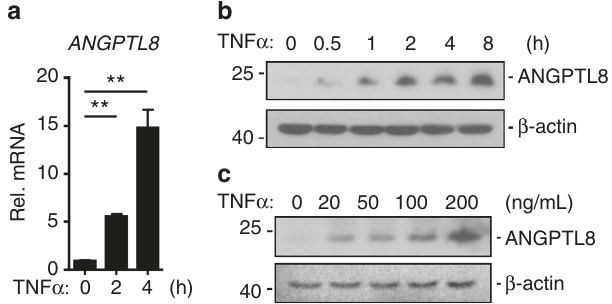
Fig. 1 TNF α upregulates the expression of ANGPTL8 in HepG2 cells. a , b The transcription level ( a , n = 3) and protein level ( b ) of ANGPTL8 after TNF α (50 ng/mL) treatment. The following experiments used the same dose of TNF α if not mentioned. c The protein level of ANGPTL8 at 8 h after different dosages of TNF α . Data are shown as the mean ± SEM, unpaired two-tailed student ’ s test was used for statistics ( a ), ** p < 0.01. Data